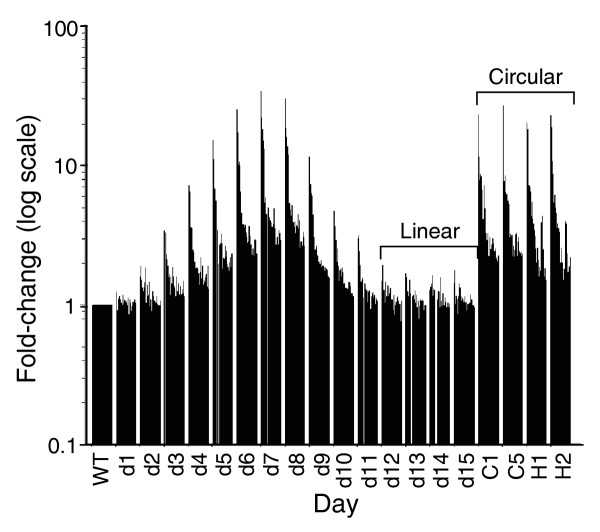
Expression signatures of cells with circular chromosomes. For each condition, the 51 genes from Table 2 that had expression changes of twofold or more in both strains C1 and C5, but not in survivors with linear chromosomes, are graphed in clusters of vertical bars. The height of each bar represents fold-change in expression relative to wild type. Survivors with linear or circular chromosomes are labeled. Strains H1 and H2 have circular chromosomes as evidenced by their inability to enter into a pulsed-field gel (data not shown). Strains H1 and H2 were not used to derive the expression signature and are shown as an independent verification of it.